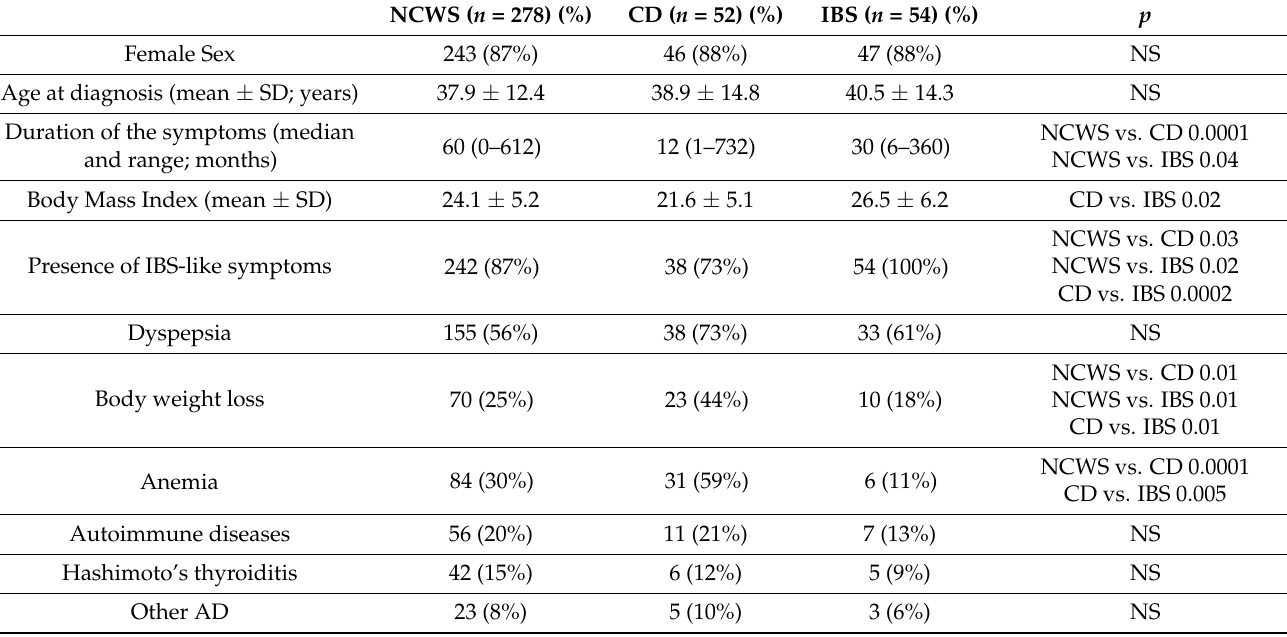
Table 1. Demographic and clinical features of the patients with NCWS, CD, and